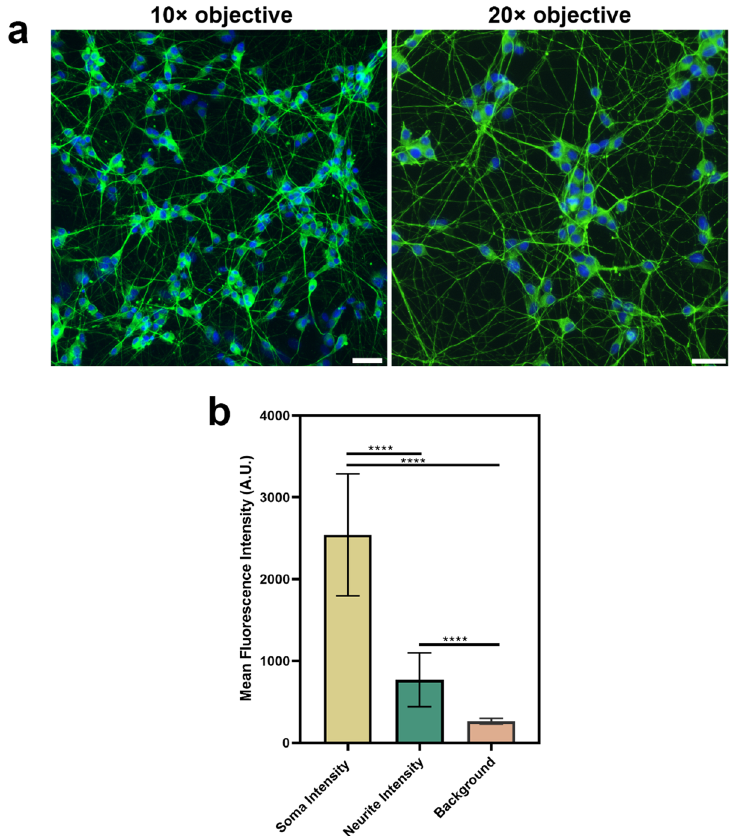
Figure 5. Image acquisition for neurite outgrowth analysis. ( a ) Comparison of images at ×10 (left) and ×20 (right) magnification (scale bars = 25 µm). Differentiated SH-SY5Y cells were labelled with βIII-tubulin and a Hoechst nuclear counterstain. βIII-tubulin images were acquired using the GFP filter (excitation 482/25 nm; emission 524/24 nm), while Hoechst nuclei images were acquired using the DAPI filter (excitation 357/44 nm; emission 447/60 nm). Although the ×10 objective increases the number of cells in the field of view, it is more difficult to visualise finer neurite processes. The ×20 objective acquires images with a higher resolution to distinguish these features. ( b ) Differences in mean fluorescence intensity of βIII tubulin between the soma, neurites and background. Analysis was performed on images acquired using a ×20 objective. Each bar represents the mean (n = 250 points) ± SD. A one-way ANOVA test and Tukey’s post-hoc analysis was performed to evaluate statistical significance where **** p <